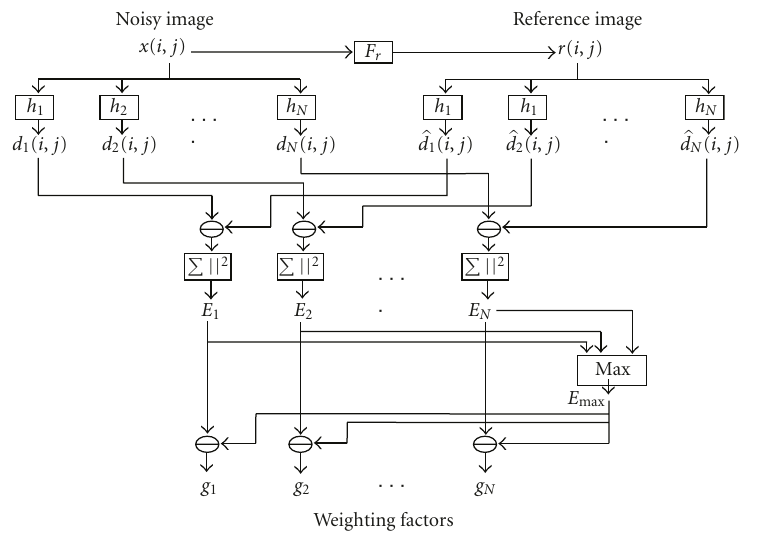
Figure 1: Weighting factor